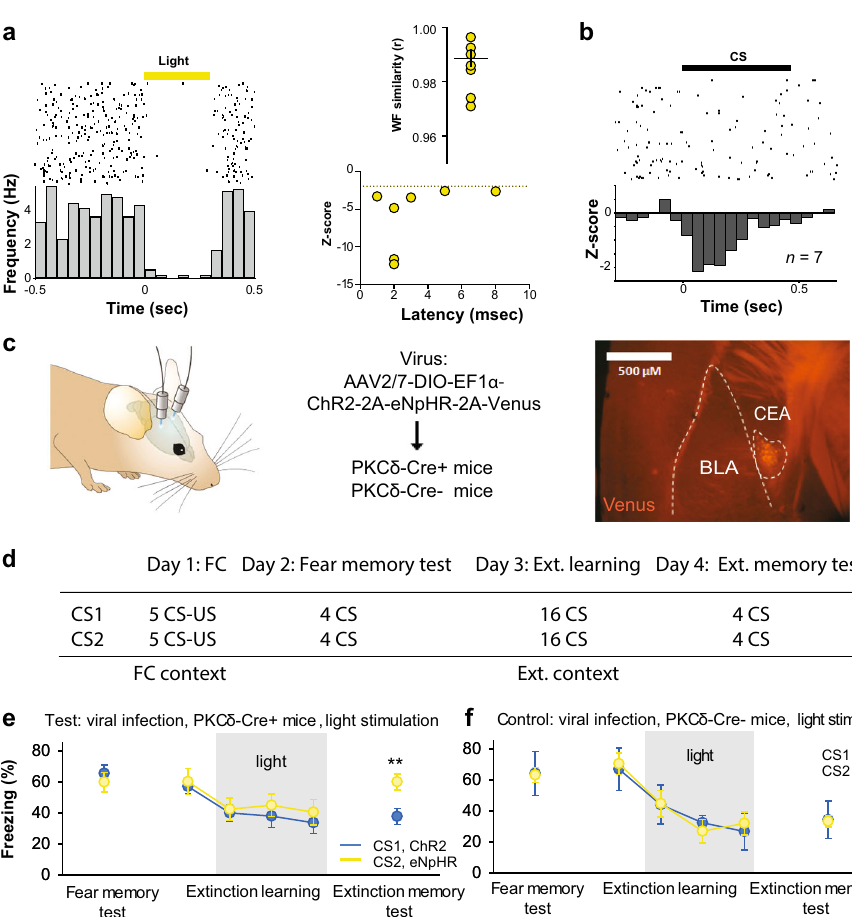
Fig. 5 PKC δ /CEloff neuronal activity during CS exposure is required for extinction memory formation. a Left, PKC δ unit identi fi ed with optogenetics. Right, waveform similarity of spikes with or without optogenetic stimulation. Bottom right, latency and magnitude of inhibition of PKC δ /CEloff neurons. b Normalized activity ( z -score, bottom) of PKC δ /CEloff cells ( n = 7) and example raster plot (top). CS: conditioned stimuli. c An adeno-associated virus (AAV2/7) conditionally expressing ChR2, eNpHR and a Venus reporter under the control of an elongation factor-1 α (EF-1 α ) promoter was injected into the CEl of a PKC δ -Cre + or PKC δ -Cre − mice (middle). Anti-GFP immunolabelling of the Venus reporter gene in CEl (right). DIO: double-inverted open reading frame; PKC δ : protein-kinase c delta; 2A: ribosomal self-processing peptide; BLA: basolateral amygdala; CEA: central amygdala. d Behavioural protocol. e Freezing response in PKC δ -Cre + mice expressing ChR2 and eNpHR in PKC δ neurons. B6 mice: n = 11; freezing, ChR2, fear memory, CS I: 65.5 ± 5.6%, extinction learning, CS I: 57.1 ± 4.5%, CS II: 39.9 ± 5.2%, CS III: 37.9 ± 7.3%, CS IV: 33.7 ± 7.0%, extinction memory, CS I: 37.7 ± 5.0. eNpHR, fear memory, CS I: 59.9 ± 6.3%, extinction learning, CS I: 60.1 ± 8.4%, CS II: 42.4 ± 7.3%, CS III: 44.9 ± 7.4%, CS IV: 40.5 ± 8.2%, extinction memory, CS I: 60.1 ± 5.2% (blocks of 4 CSs). Main effect of CS presentations during extinction learning: two-way repeated-measures ANOVA F (5,49) = 8.7, p < 0.001. Interaction of light stimulation and CS presentations: two-way repeated-measures ANOVA F (5,49) = 2.34, p = 0.056 followed by post hoc Bonferroni t -test vs. CS1 block during fear memory, p < 0.01. All values are expressed as means ± SEM. f Control experiment. Freezing response in PKC δ -Cre − mice not expressing ChR2 and eNpHR in PKC δ neurons. B6 mice: n = 5; freezing, blue light, fear memory, CS I: 63.1 ± 4.9%, extinction learning, CS I: 70.4± 9.7%, CS II: 44.6 ± 15.0%, CS III: 26.8 ± 8.2%, CS IV: 31.8 ± 13.5%, extinction memory, CS I: 33.2 ± 3.8%. Yellow light, fear memory, CS I: 64.1 ± 14.2%, extinction learning, CS I: 66.9 ± 12.2%, CS II: 43.9 ± 6.1%, CS III: 32.2 ± 4.1%, CS IV: 26.6 ± 5.7%, extinction memory, CS I: 34.1 ± 12.1% (blocks of 4 CSs). Main effect of CS presentations during extinction: two-way repeated-measures ANOVA F (5,20) = 15.5, p < 0.001. Interaction of light stimulation and CS presentations: two-way repeated- measures ANOVA F (5,20) = 0.12, p = 0.987 followed by post hoc Bonferroni t -test vs. CS1 block during fear memory, p > 0.05 for all comparisons. All values are expressed as means ± SEM. Source data are provided as a Source data fi